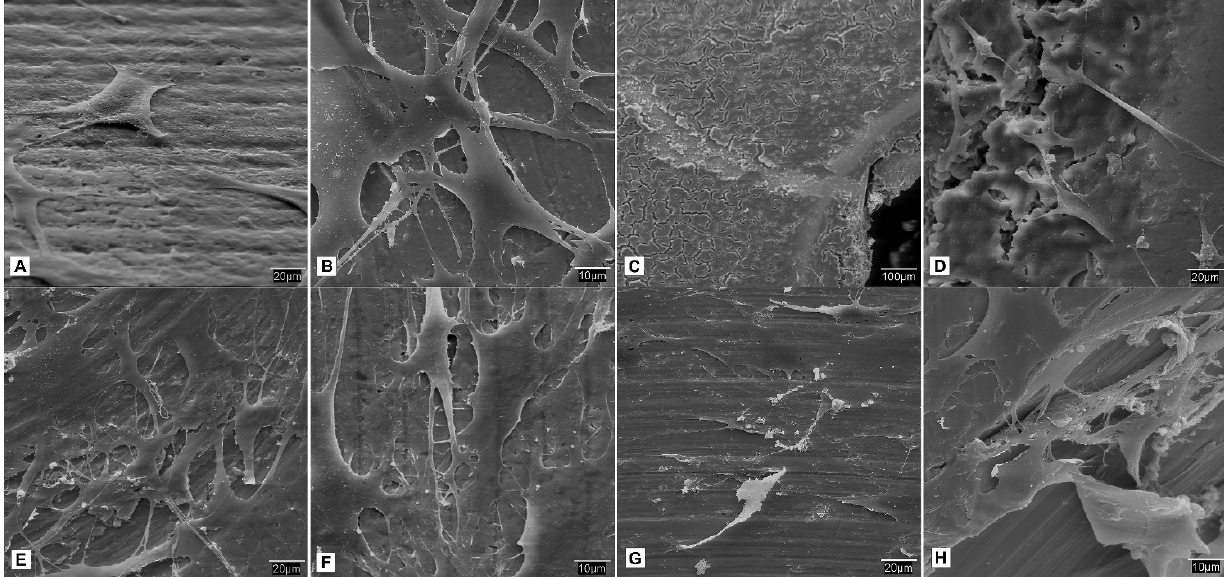
Figure 8. S.E.M. Study of the sowing of fibroblasts in different incubation periods: ( A ) Acid + BMP-2 treated screws after 24 h at 500×; ( B ) Screws treated with acid + BMP-2 after 24 h at 1000× where it can be seen how the cells adhere and expand over the treated surface of the titanium, growing in multilayer, which contrasts with the large amount of vesicles observed previously in the control group; ( C ) Screws treated with acid + BMP-2 after 14 days at 100× ; ( D ) Screws treated with acid + BMP-2 after 14 days at 500×; ( E ) Screws treated with acid + BMP-2 after 21 days at 500×; ( F ) Screws treated with acid + BMP-2 after 21 days at 1000×; ( G ) Screws treated with acid + BMP-2 after 28 days at 500×; ( H ) Screws treated with acid + BMP-2 after 2 at 1000× where areas of slight cellular denudation are evident.